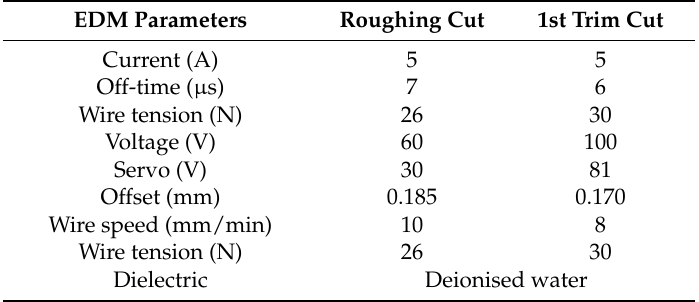
Table 1. Industrial settings for the roughing and first trim cut as taken from the ONA AV35 WEDM machine tables.